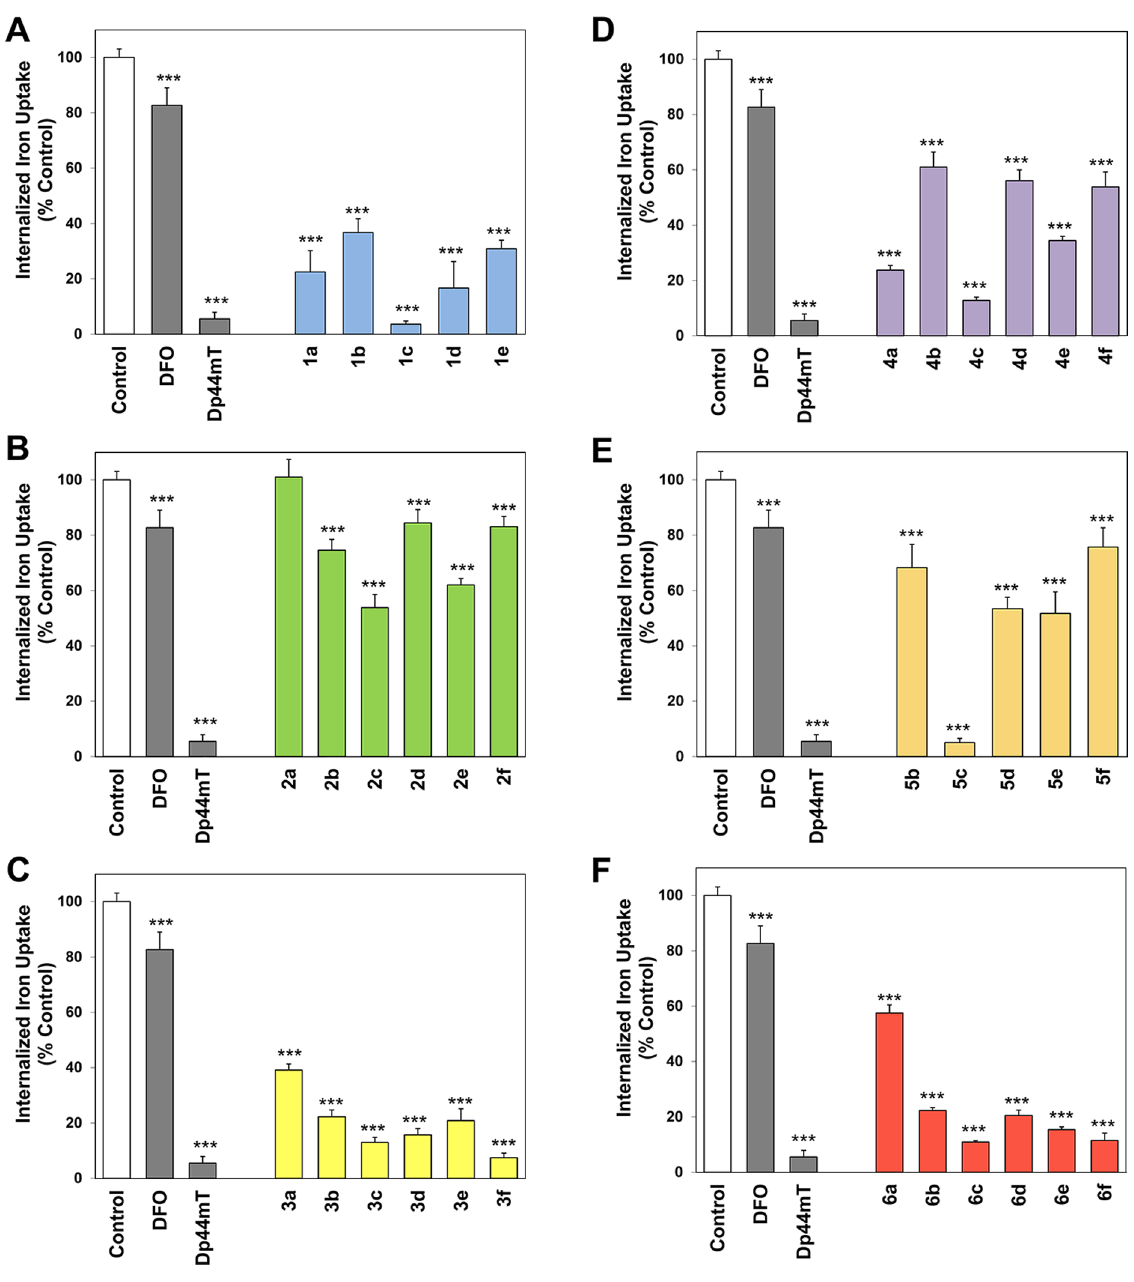
Figure 8. Effect of (A) series 1, (B) series 2, (C) series 3, (D) series 4, (E) series 5 and (F) series 6 chelators, relative to the controls DFO and Dp44mT, on 59 Fe uptake from 59 Fe-transferrin by SK-N-MC cells. Cells were incubated for 3 h/37 u C with 59 Fe-transferrin (0.75 m M) in the presence or absence of the chelators (25 m M). At the end of this incubation, cells were washed 4 times with ice-cold PBS. Internalization of 59 Fe was assessed by incubation for 30 min/4 u C with the protease, Pronase (1 mg/mL). Cellular 59 Fe was then assessed using a c -scintillation counter. Results are mean 6 SD (3 experiments).